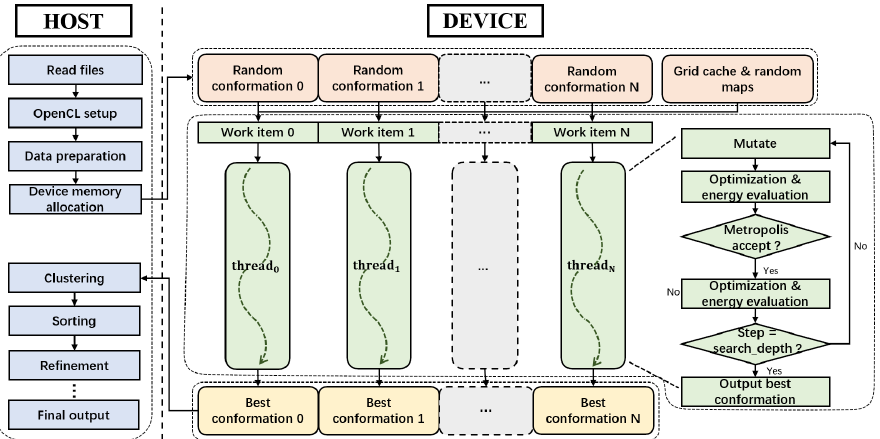
Figure 1. The OpenCL architecture for implementing Vina-GPU, which consists of a host (CPU) and a device (GPU) part of execution. The device part implements thousands of docking threads, each of which is assigned with an OpenCL work item to perform a Monte Carlo-based local search method with largely reduced search iterations.